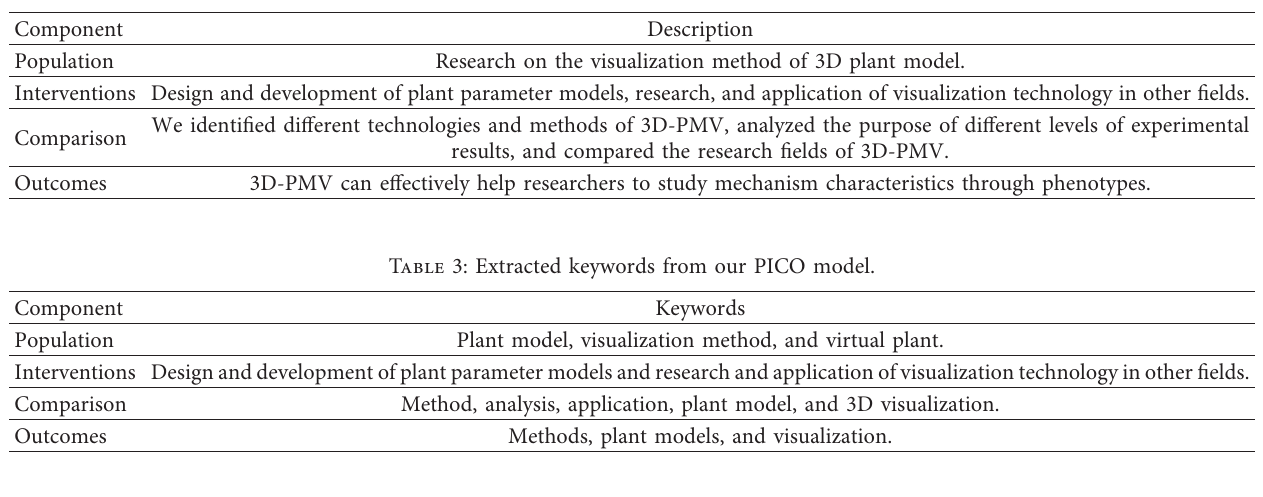
Table 2: Description of our PICO model combined with 3D-PMV.